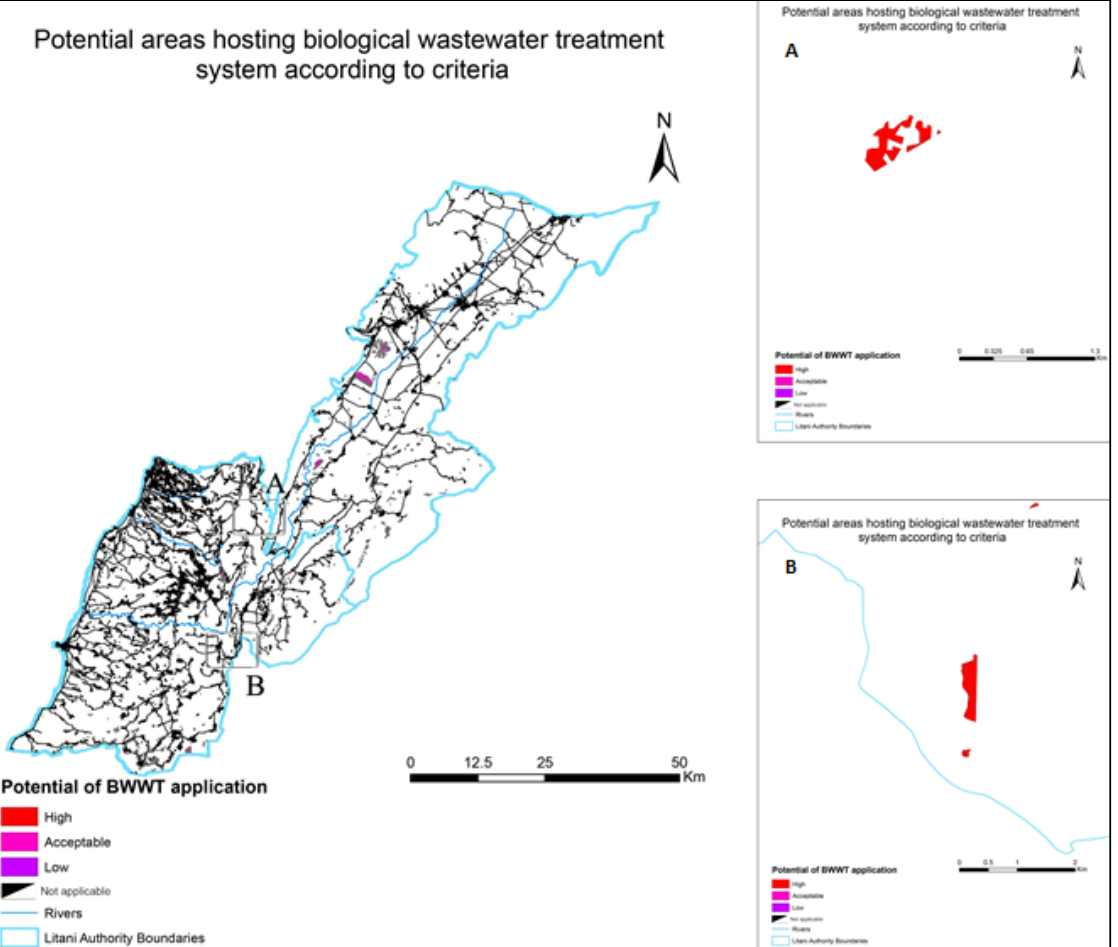
Figure 3. Potential areas hosting BWWT system in the Litani River Basin based on fuzzy function of standardized spatial criteria. ( A , B ) Detailed locations .